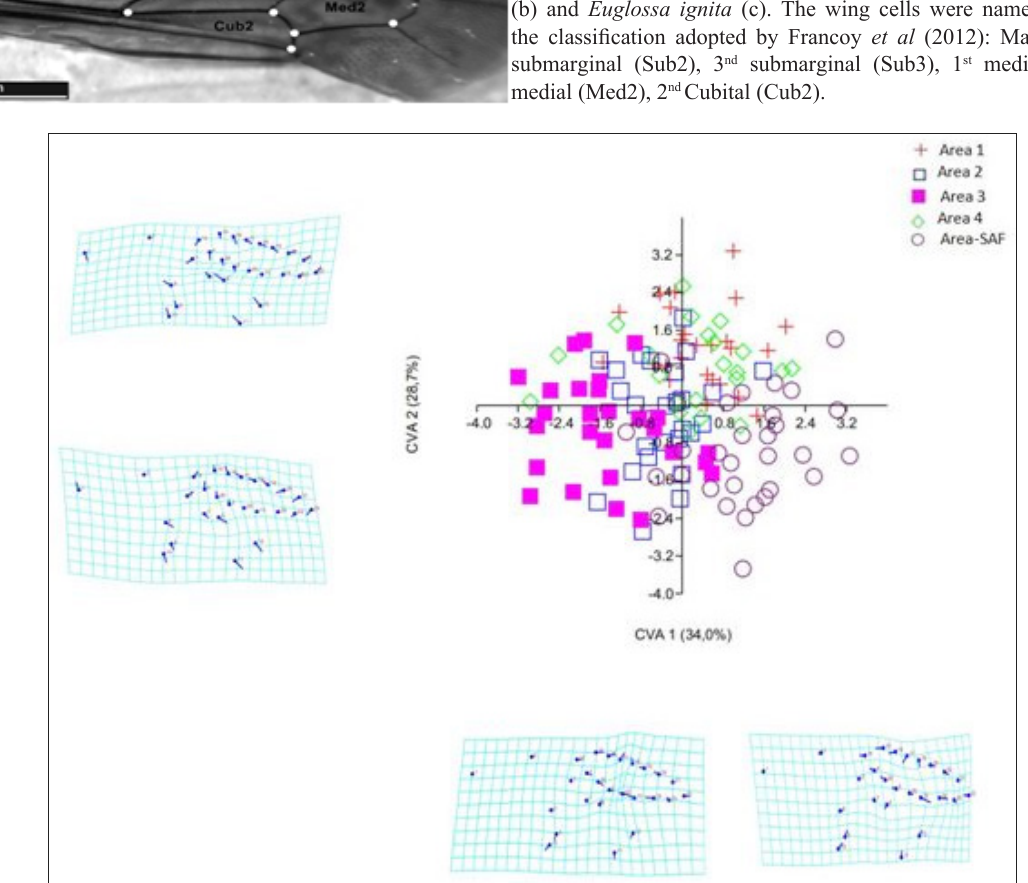
Fig 1 . Landmarks (points) and semilandmarks (circles) used for shape and size of the wing analysis of Eulaema atleticana (a), Euglossa cordata (b) and Euglossa ignita (c). The wing cells were named according to the classification adopted by Francoy et al (2012): Marginal (M), 2 nd submarginal (Sub2), 3 nd submarginal (Sub3), 1 st medial (Med1), 2 nd medial (Med2), 2 nd Cubital